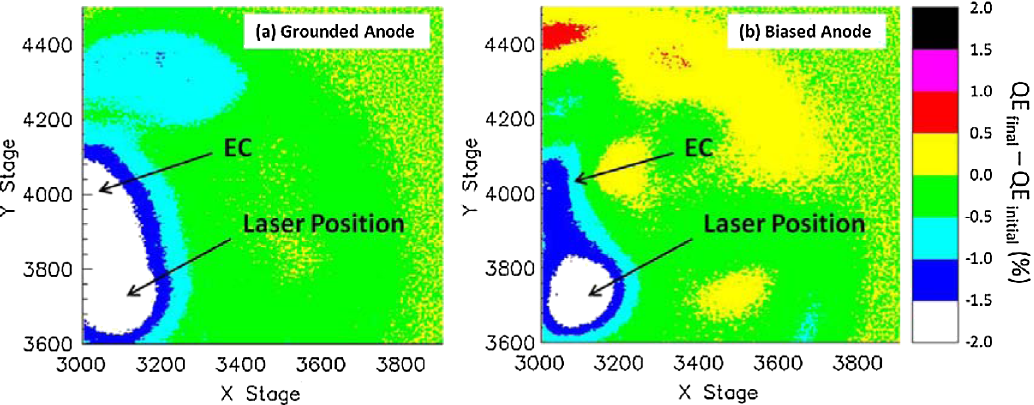
FIG. 12. The change in QE (final–initial) for running with both (a) grounded anode and (b) biased anode configurations is shown. The false color corresponds to the absolute change in QE over the photocathode, notably at the laser spot location ( x ¼ 3100 , y ¼ 3700 ) and EC ( x ¼ 3000 , y ¼ 4000 ).